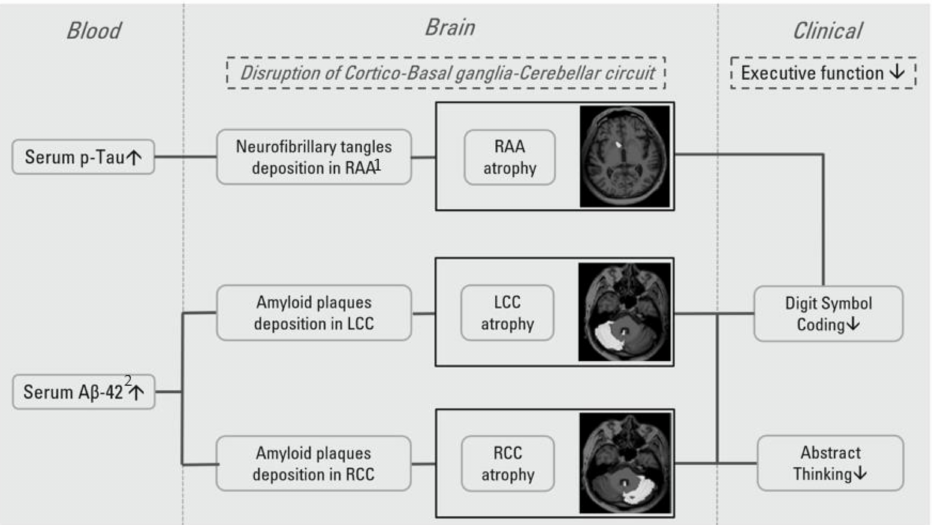
Figure 3. Misfolded deposition contributes to gray matter atrophy and cognitive dysfunction. We hypothesized that misfolded protein deposition in specific ROIs causes mediation effects. Plasma misfolded protein deposition is indicated and has a positive correlation with misfolded protein level in the brain. Deposition of p-Tau in RAA causes brain gray matter atrophy and is correlated with DSC and A β -42 in RAA and the bilateral cerebellum, mediated by executive function including ABS and DSC. This function includes the striato-thalamocortical circuit and cerebellum (cortico-basal ganglia-cerebellar circuit). Interconnections between cognitive regions of the basal ganglia, the cerebellum, and the cerebral cortex could provide part of the foundation for the executive control network. Misfolded protein accumulation in brain tissues with neuron toxicity leads to neuron death and causes gross brain structural changes such as gray matter atrophy, which are in turn correlated with clinical disease progression and cognitive function impairments. 1 RAA: right accumbens area, 2 A β -42: